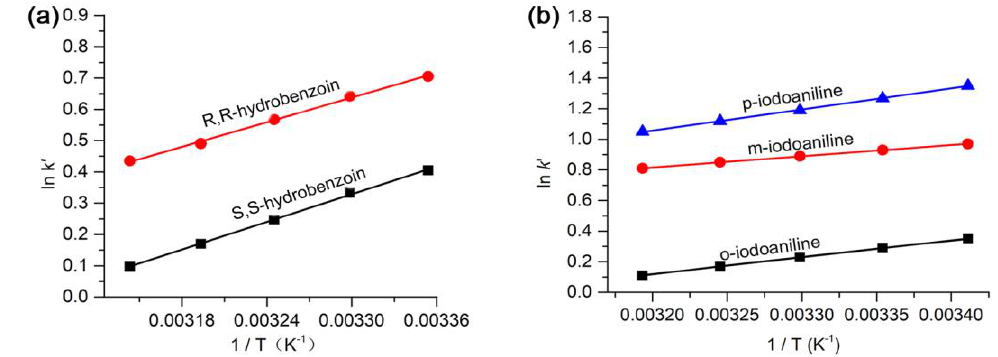
Figure 7. Van’t Hoff curves obtained for ( a ) hydrobenzoin and ( b ) iodoaniline. Table 3. ∆ H , ∆ S , ∆ G and correlation coefficient ( R 2 ) values for the separation of hydrobenzoin and